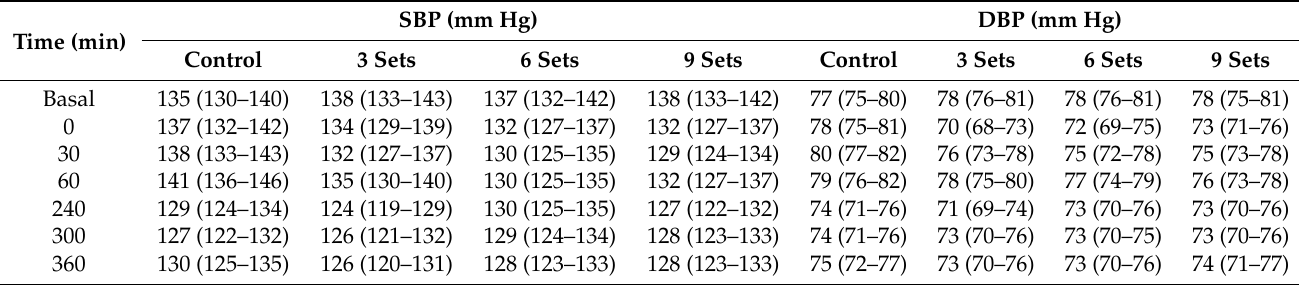
Table 2. Basal and post-exercise effects on SBP and DBP. Least square means (95% CI).